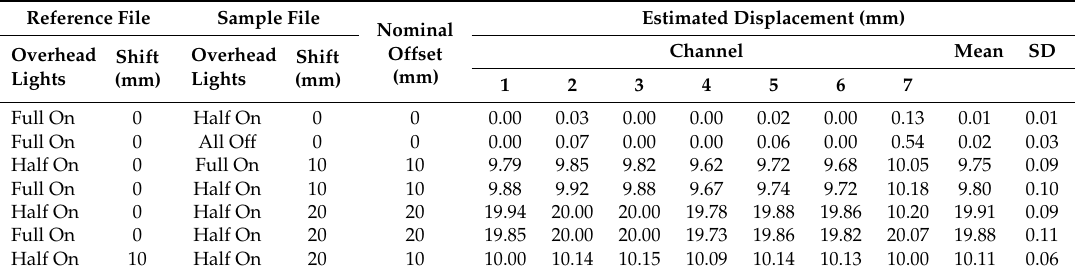
Table 3. Displacement estimates for indoor test with no front-end